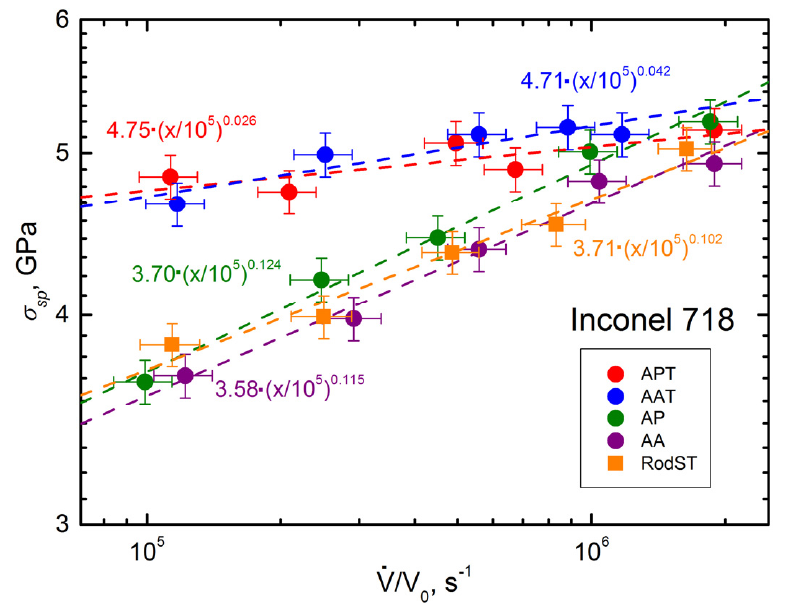
Figure 6. Dependences of the spall strength of the cast Inconel 738 alloy and alloy manufactured by DLD method on the strain rate.